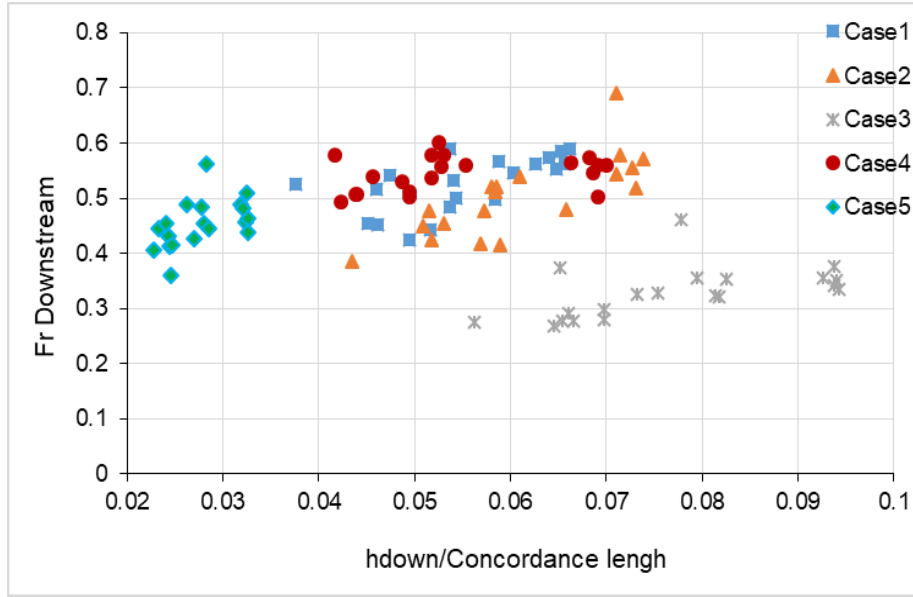
Figure 7. Relation between downstream Froude number and h_downstream⁄(concordance length )